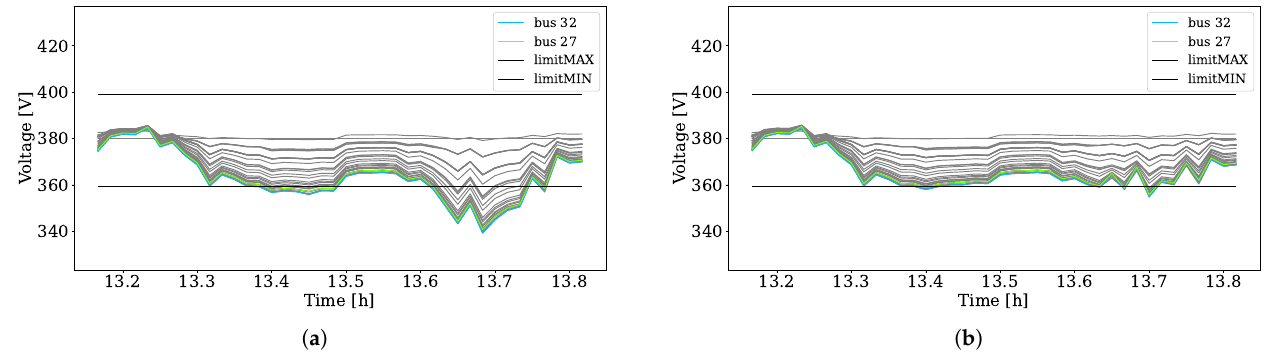
Figure 17. Results without the online control 2. ( a ) Voltage with no online control applied; ( b ) voltage with online